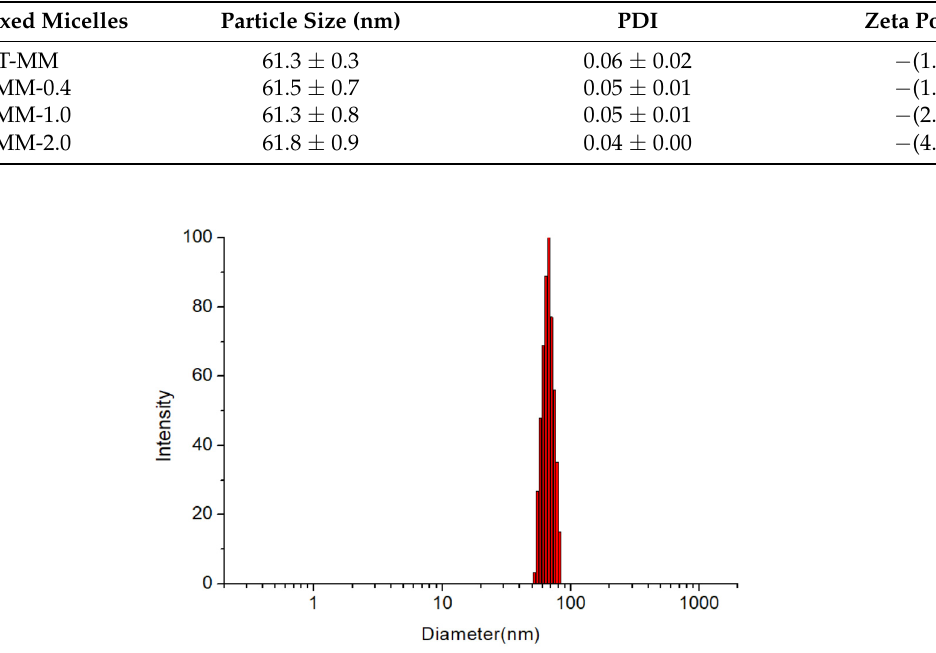
Figure 3. Plots of ultraviolet absorbance of I 2 versus concentration of the mixed micelles in water. sorbance is observed. The orange and blue dots represent the polymer concentrations before and curves represents the CMC. (Mean ± SD, n = 3).